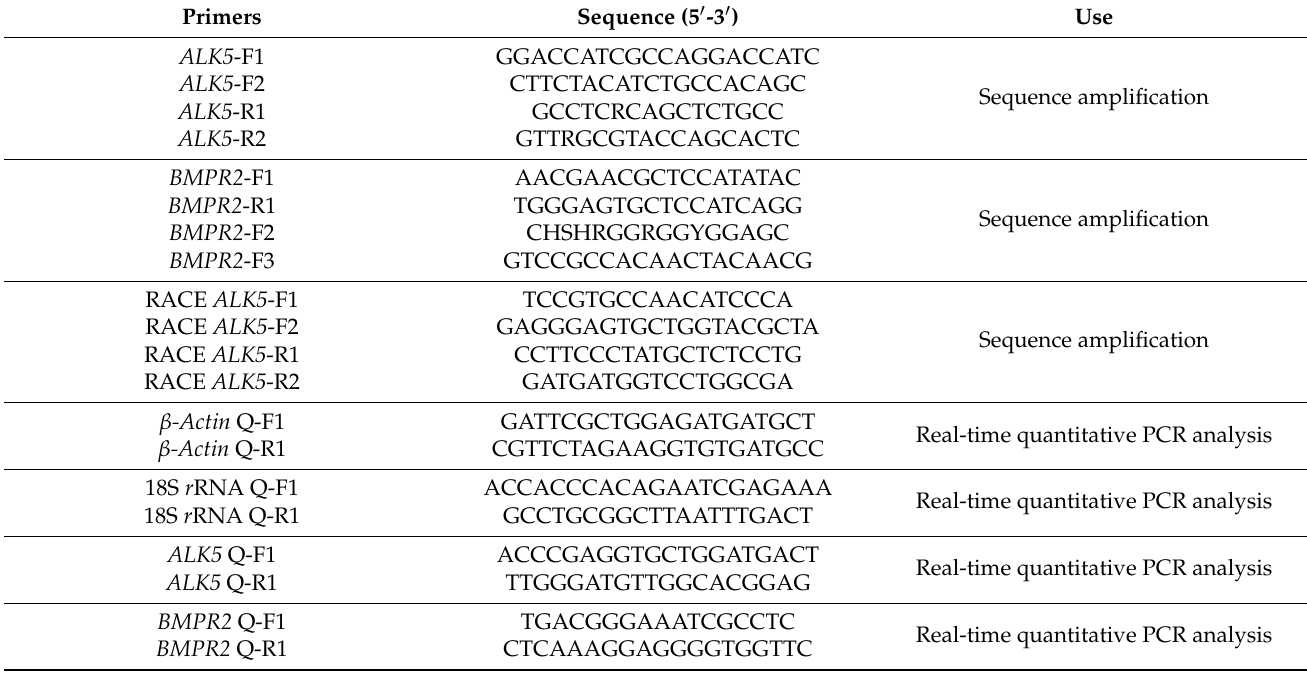
Table 1. Sequences of oligonucleotide primers used in this